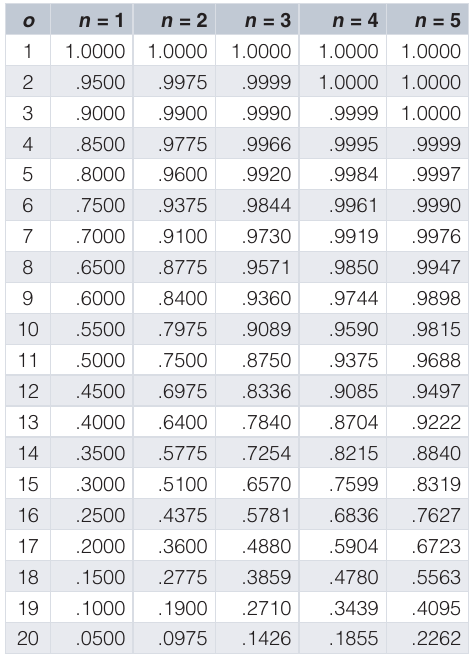
Table 2. Probability of obtaining at least an outcome o once, across n d20